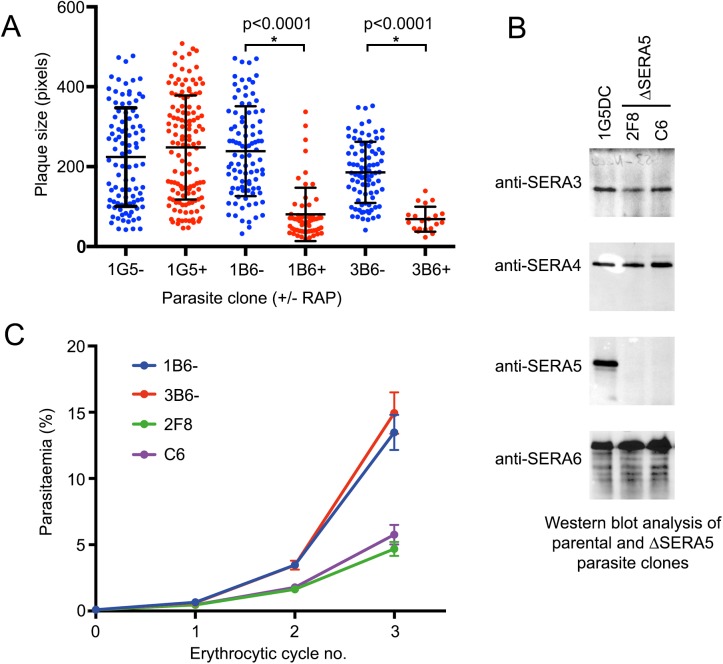
ΔSERA5 parasite clones show a replication defect but SERA5 is not essential for asexual blood stage growth in vitro.(A) Scatter plots showing plaque numbers and distribution of plaque sizes obtained following treatment of the parental 1G5DC clone or conditional knockout clones floxSERA5-1B6 and floxSERA5-3B6 with DMSO (control, mock-treated) or RAP to induce disruption of the SERA5 gene. In each case plaque numbers were counted from a total of 24 microwells. Note that plaque numbers were lower in the RAP-treated floxSERA5-1B6 and floxSERA5-3B6 clones (n = 60 and 20 respectively) than in the mock-treated samples (n = 94 and 86 respectively). Plaque dimensions in scanned images of the plates were quantified using the Lasso tool of Photoshop CS6 (Adobe). Horizontal bars, mean plaque area ±1 SD. Brackets and asterisks indicate parasite populations for which statistically different plaque sizes were obtained (Student’s two-tailed t-test). The difference in plaque size for the +/- RAP-treated parental 1G5DC parasites were not significant (p-value = 0.1564). (B) Western blot confirmation of ΔSERA5 parasite clones obtained from plaque assay wells containing a single plaque. Clone 2F8_ΔSERA5 (derived from RAP-treated clone floxSERA5-1B6) and C6_ΔSERA5 (derived from RAP-treated clone floxSERA5-3B6) were expanded, then schizont extracts probed with antibodies to SERA3, SERA4, SERA5 and SERA6. (C) Growth assay showing relative replication rates of ΔSERA5 P. falciparum clones 2F8_ΔSERA5 and C6_ΔSERA5 compared to their parental floxSERA5-1B6 and floxSERA5-3B6 clones (not RAP-treated), over 3 erythrocytic cycles. Cultures were fed daily by replacing the medium, but were not passaged by addition of fresh erythrocytes. Parasitaemia values were determined by FACS as described in Materials and Methods. Data are averaged from 3 independent biological replicate experiments. Error bars, ±SEM. Relative to the parental parasites, the ΔSERA5 clones showed a mean reduction in replication rate per cycle of 28±3%.